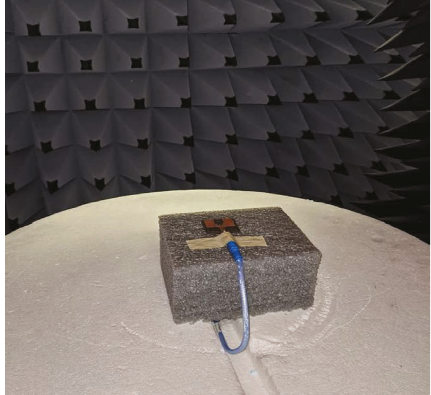
Figure 5: Fabricated prototype within the anechoic